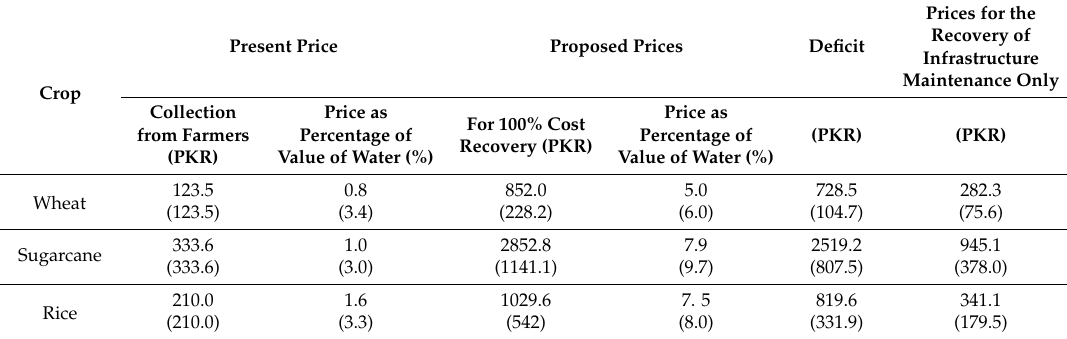
Prices for the Recovery of Infrastructure Maintenance